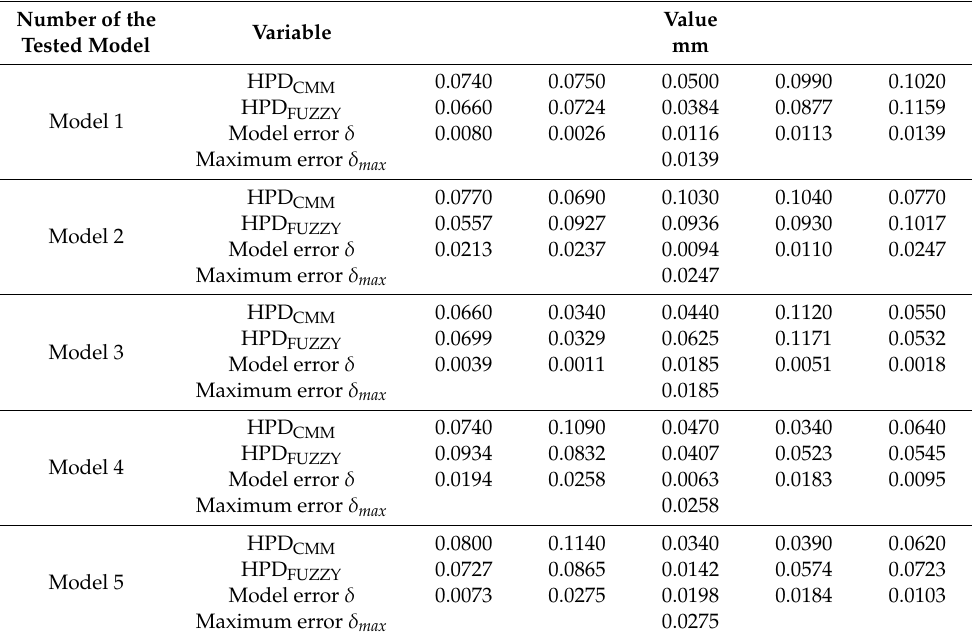
Figure 14. Surfaces of neuro-fuzzy models after the learning process for five learning sets. ( a ) Surface of model 1 for the first set of learning data. ( b ) Surface of model 2 for the second set of learning data. ( c ) Surface of model 3 for the third set of learning data. ( d ) Surface of model 4 for the fourth set of learning data. ( e ) Surface of model 5 for the fifth set of learning data. The color represents the value of the HDP CMMn variable. Model surfaces refer to normalized variables, therefore there are no length units on the axes. Table 3. Test results of neuro-fuzzy